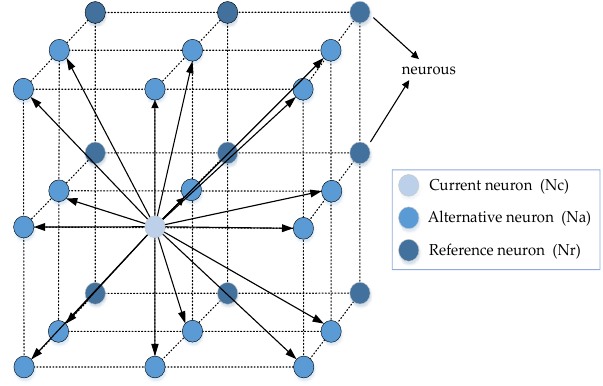
Figure 2. Local space model.